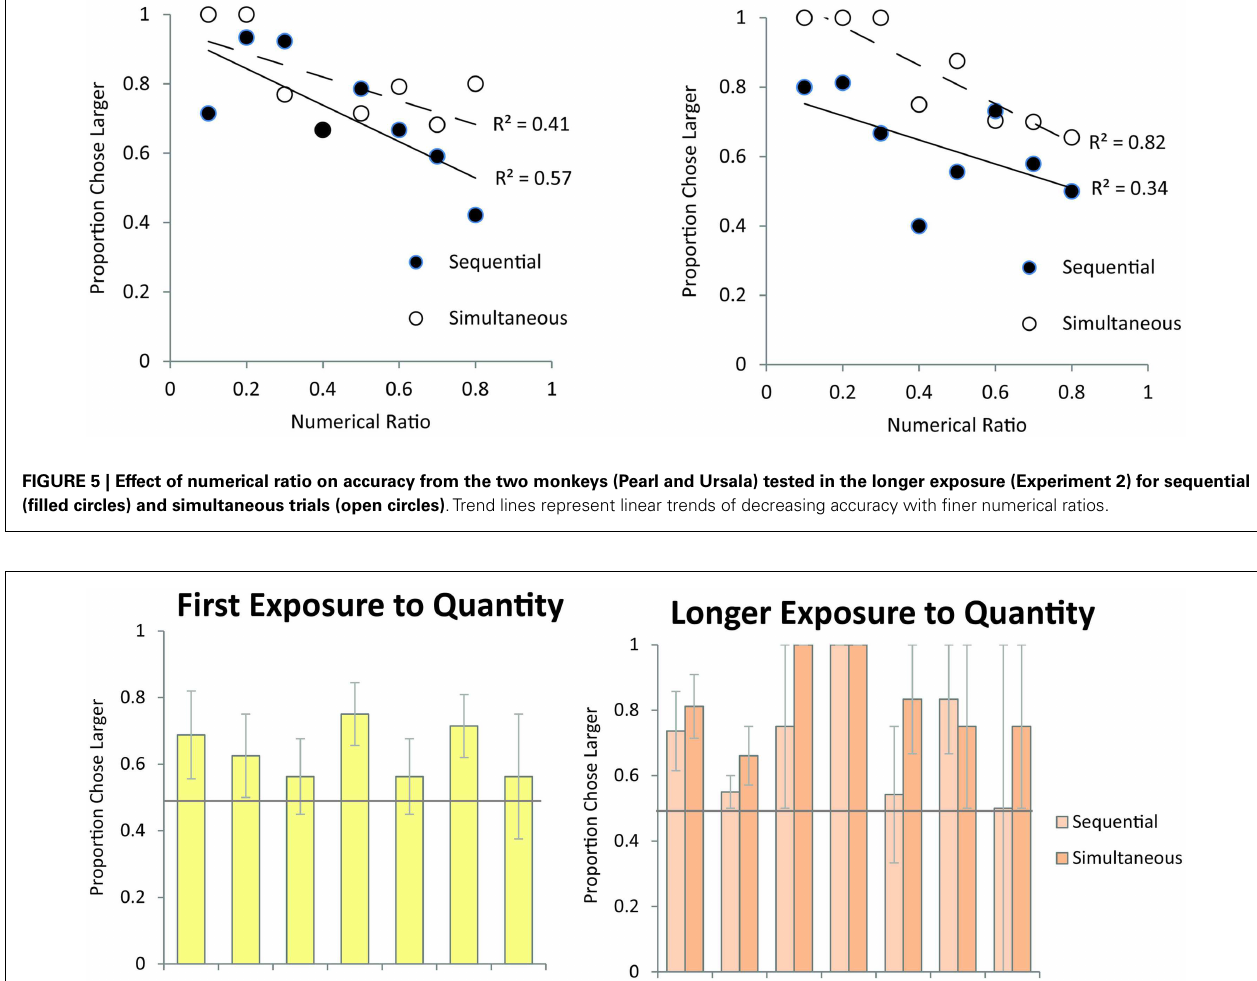
FIGURE 6 | Monkeys’ accuracy on numerical pairs which have been previously reported to elicit failures under the object-file system . In contrast to the predictions of the object-file model, monkeys performed significantly above chance across these pairs on their first exposure to